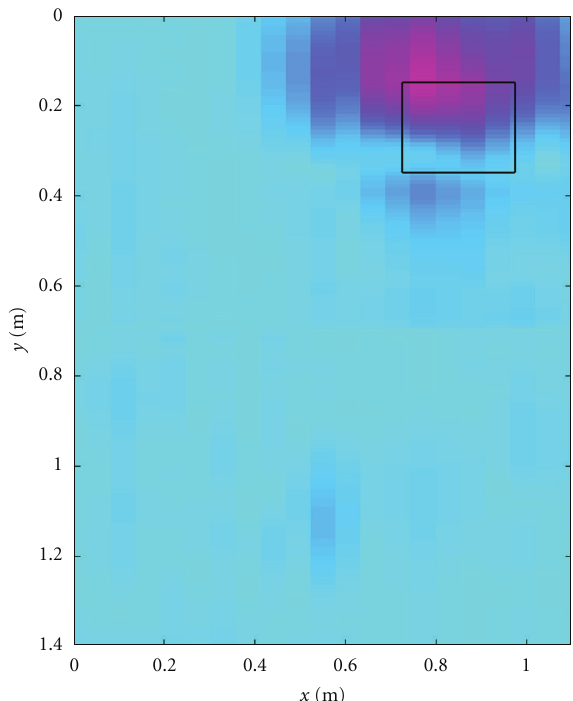
Figure 8: Constant depth slice at the depth of about 80 cm, achieved from